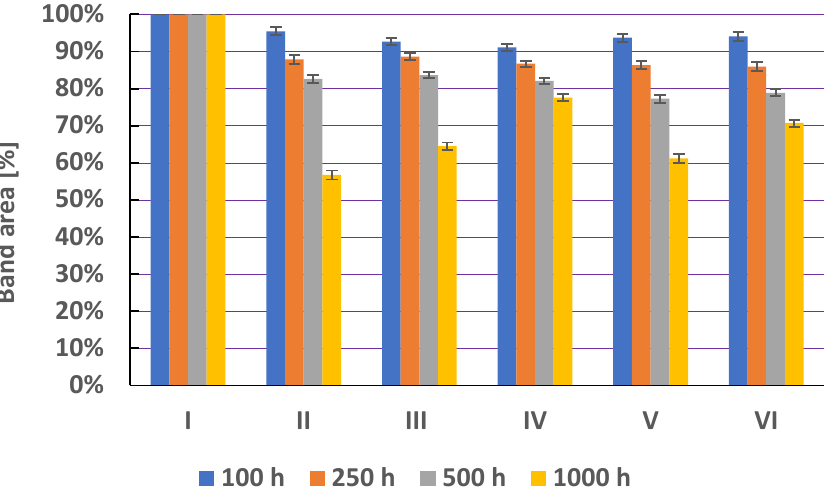
Figure 12. The comparison of means area ( ± SD) (in %) of chromatographic bands obtained from tinidazole (T) in different solvents (I—in water at pH = 2.62; II—in water at pH = 5.56; III—in water at pH = 8.21; IV—in hydrogen peroxide (3%); V—in physiological salt (0.9% NaCl); and VI—in methanol) which were heated at 40 ◦ C for 100, 250, 500, and 1000 h, where SD is the standard deviation.